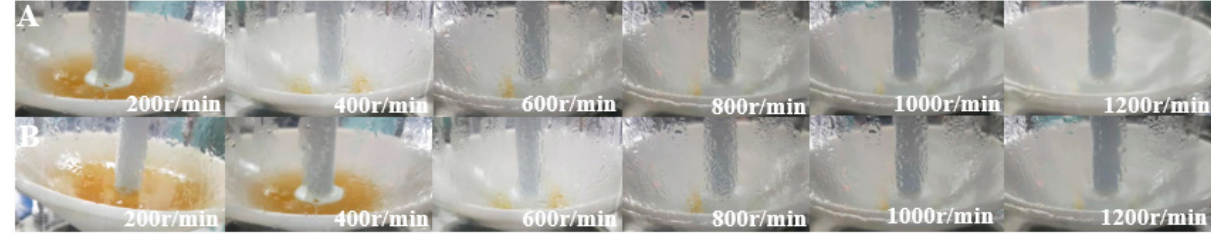
Figure 4. Film forming characteristics of wort at different speeds: ( A ) 40 L/h; ( B ) 80 L/h.